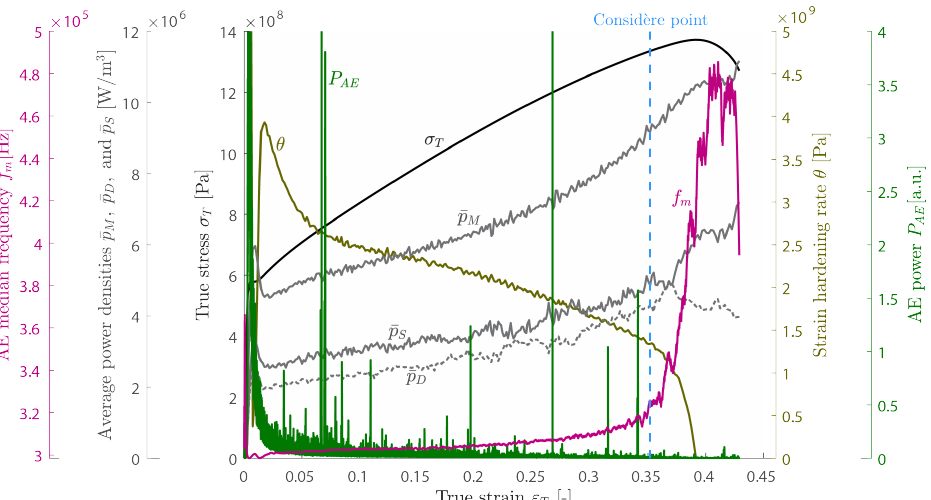
Figure 15. Summary of results of the tensile test, representing the behaviour of the expended and stored mechanical power— p M and p S , respectively, dissipated heat p D , and the strain hardening rate θ , synchronised with the stress-strain curve and the key descriptive AE variables—power P AE and median frequency of the PSD f m